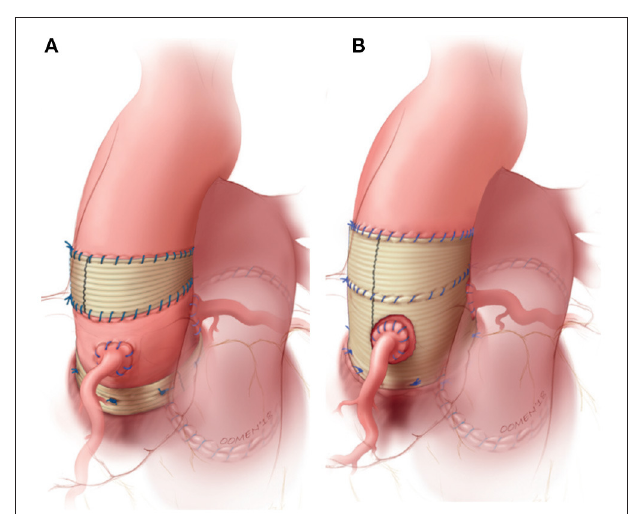
FIGURE 2 | Most commonly used strategies to externally support the freestanding pulmonary autograft. (A) External subvalvular annuloplasty and sinotubular junction (STJ) stabilization in patients with risk factors for autograft dilatation. (B) Wrapping of the entire autograft within a cylinder of vascular tube graft. Figure adapted with permission from Mazine et al.